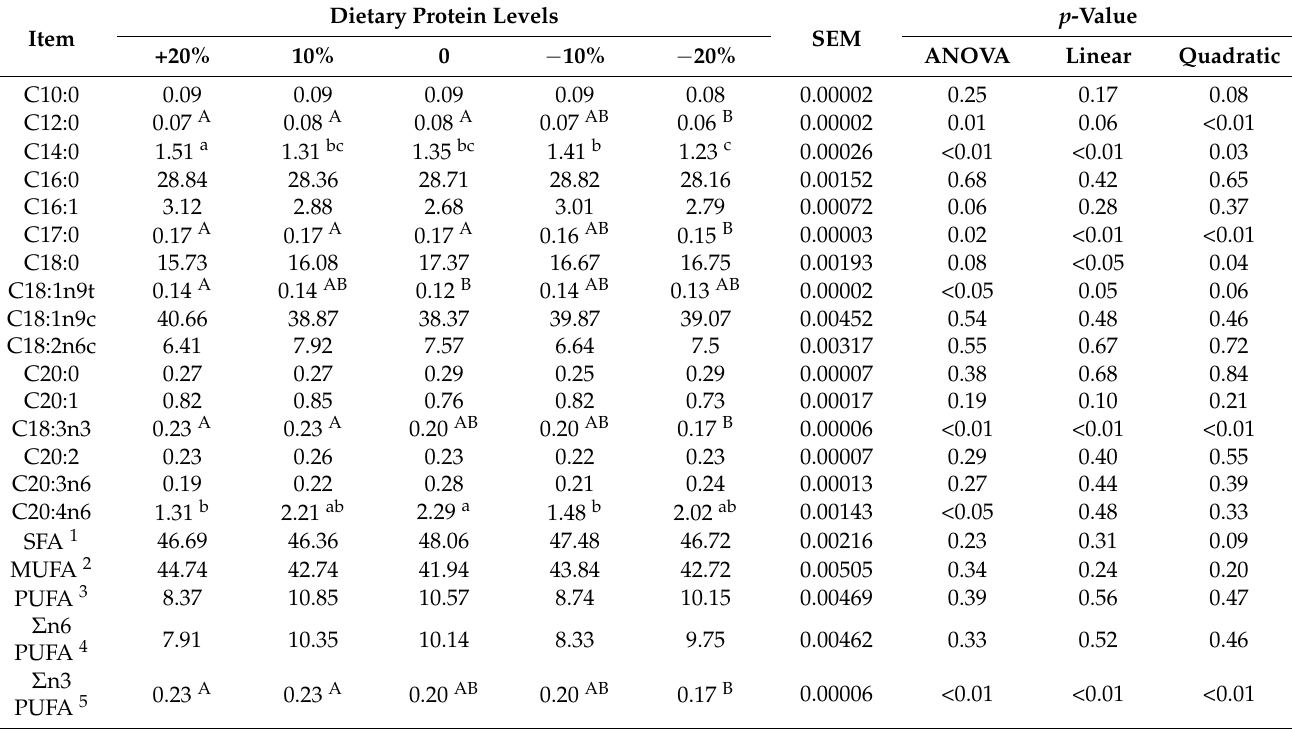
Table 6. Effects of long-term protein restriction on fatty acid composition in longissimus thoracis muscle of Shaziling pigs.